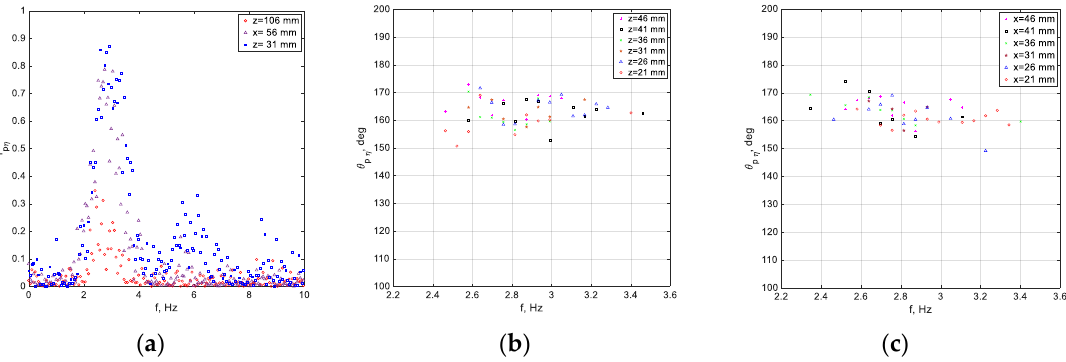
Figure 12. Correlation between fluctuations of the static pressure in the air above the water and the surface elevation. ( a ) Cross-correlation coefficients r pη between the static pressure fluctuations at various heights, and the surface elevation variations, for U max = 11.2 m/s at fetch x = 340 cm; ( b ) Phase shifts around the peak frequency at U max = 11.2 m/s = 300 cm; ( c ) as in (b) for x = 340 cm.